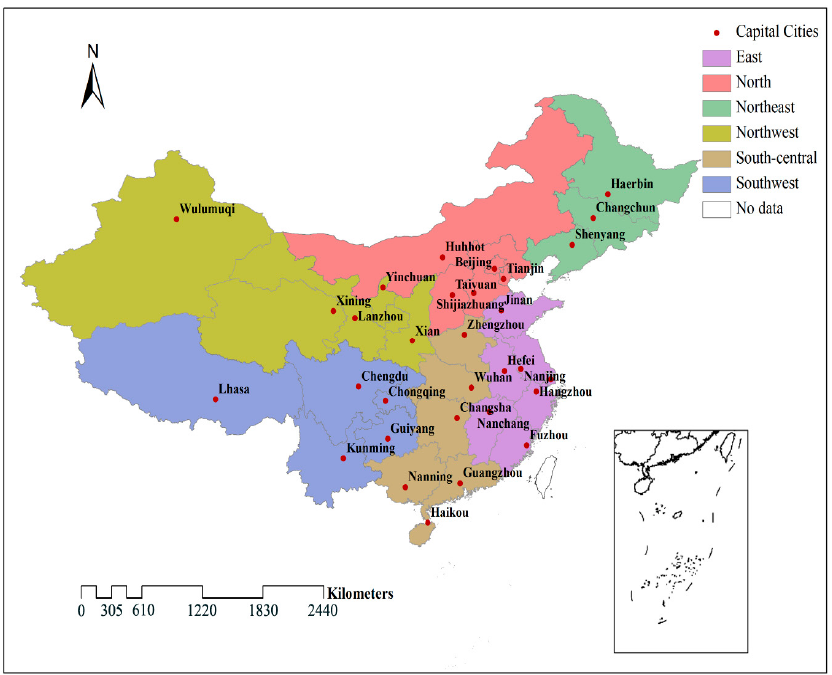
Figure 1. The distribution of the researched cities.